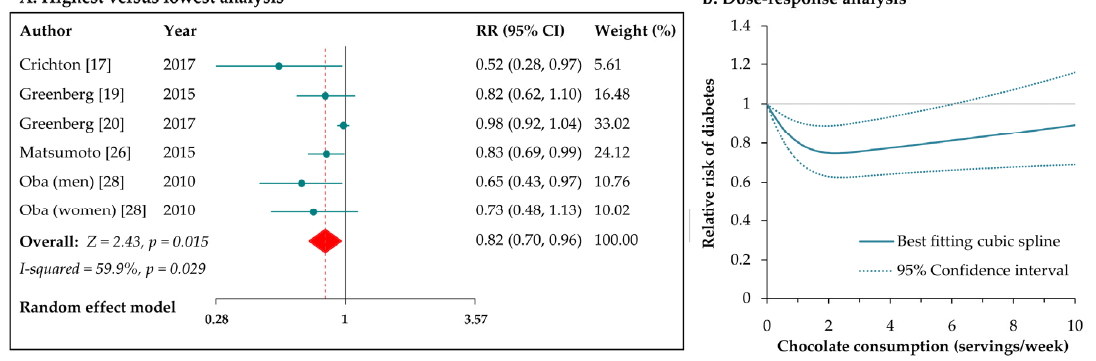
Figure 4. Meta ‐ analyses of chocolate consumption and risk of diabetes. Figure 4. Meta-analyses of chocolate consumption and risk of